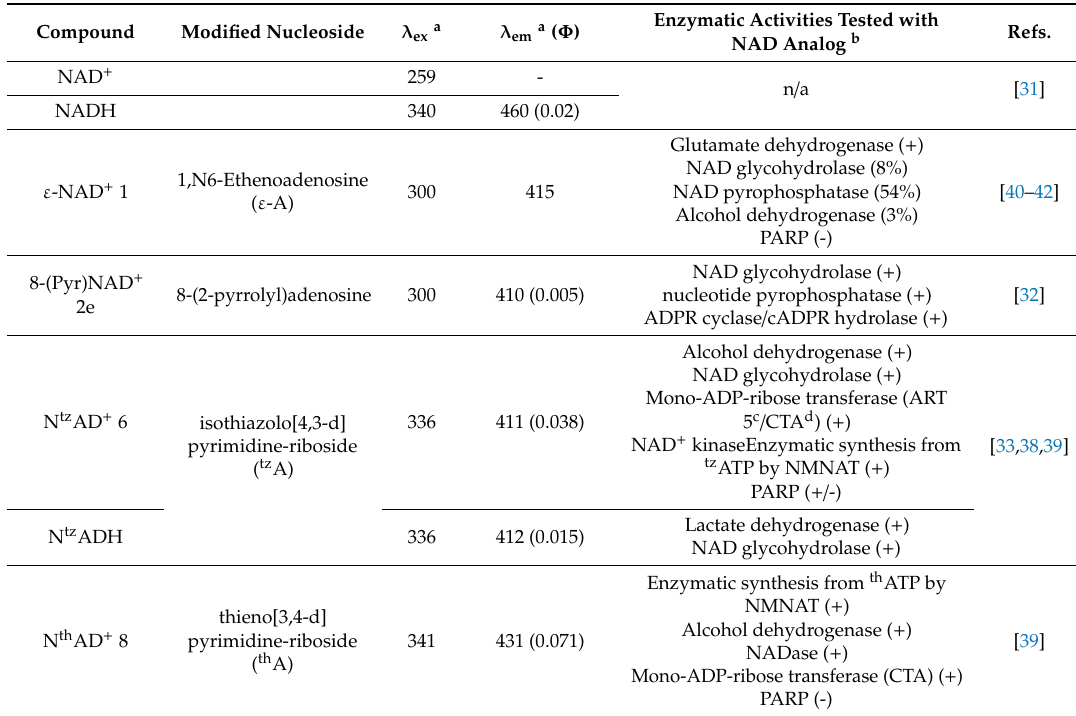
Table 1. Optical properties of NAD and select adenosine-modified emissive NAD